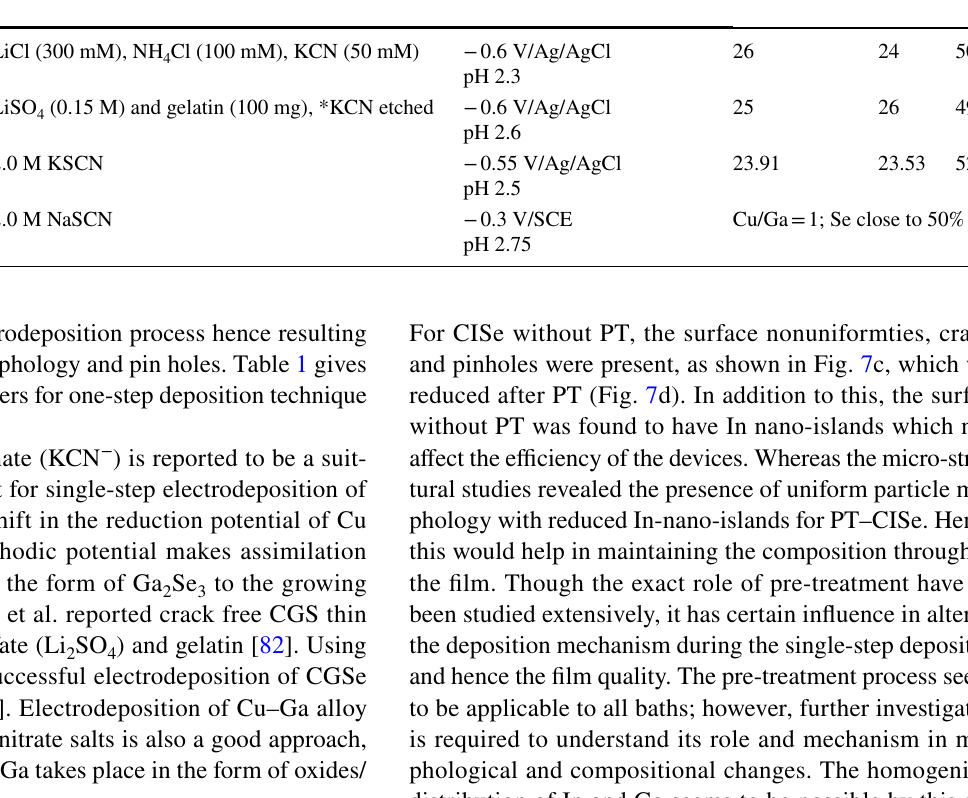
Table 1 CGSe electrodeposition conditions and their compositions Bath composition Cu– Complexing agents and supporting electrolyte Ga–Se (mM) *Etching